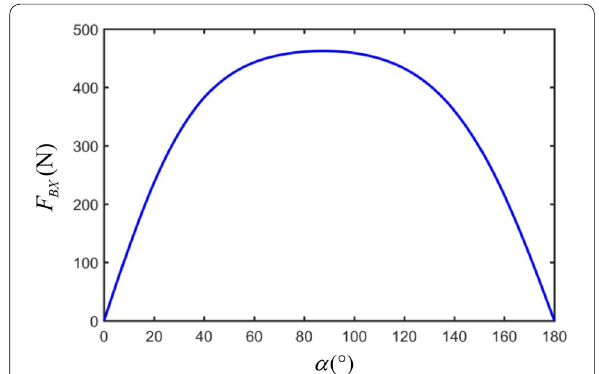
Figure 11 The horizontal forces on the column F BX under mechanism